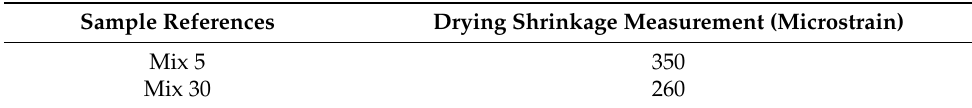
Table 5. Drying Shrinkage Measurement at 28 days of curing